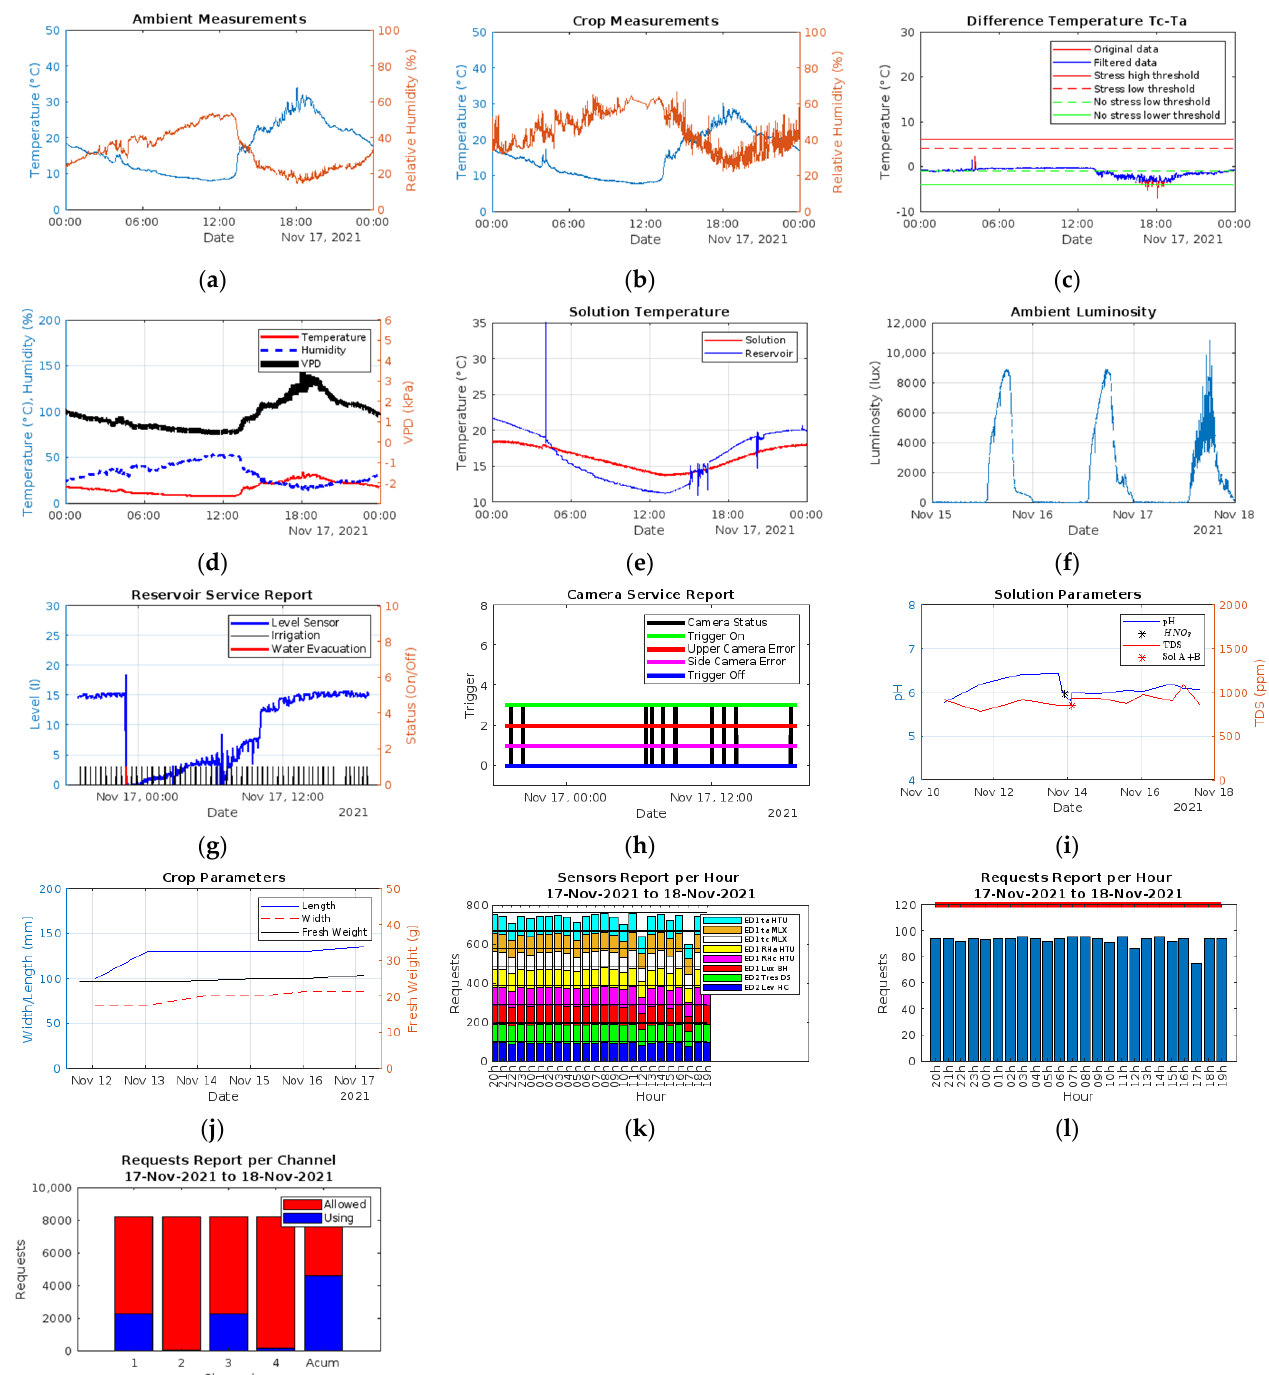
(j) crop evolution, (k) report of successful sensor readings/h, (l) requests sent to the server per hour and (m) total requests sent to the server per channel.